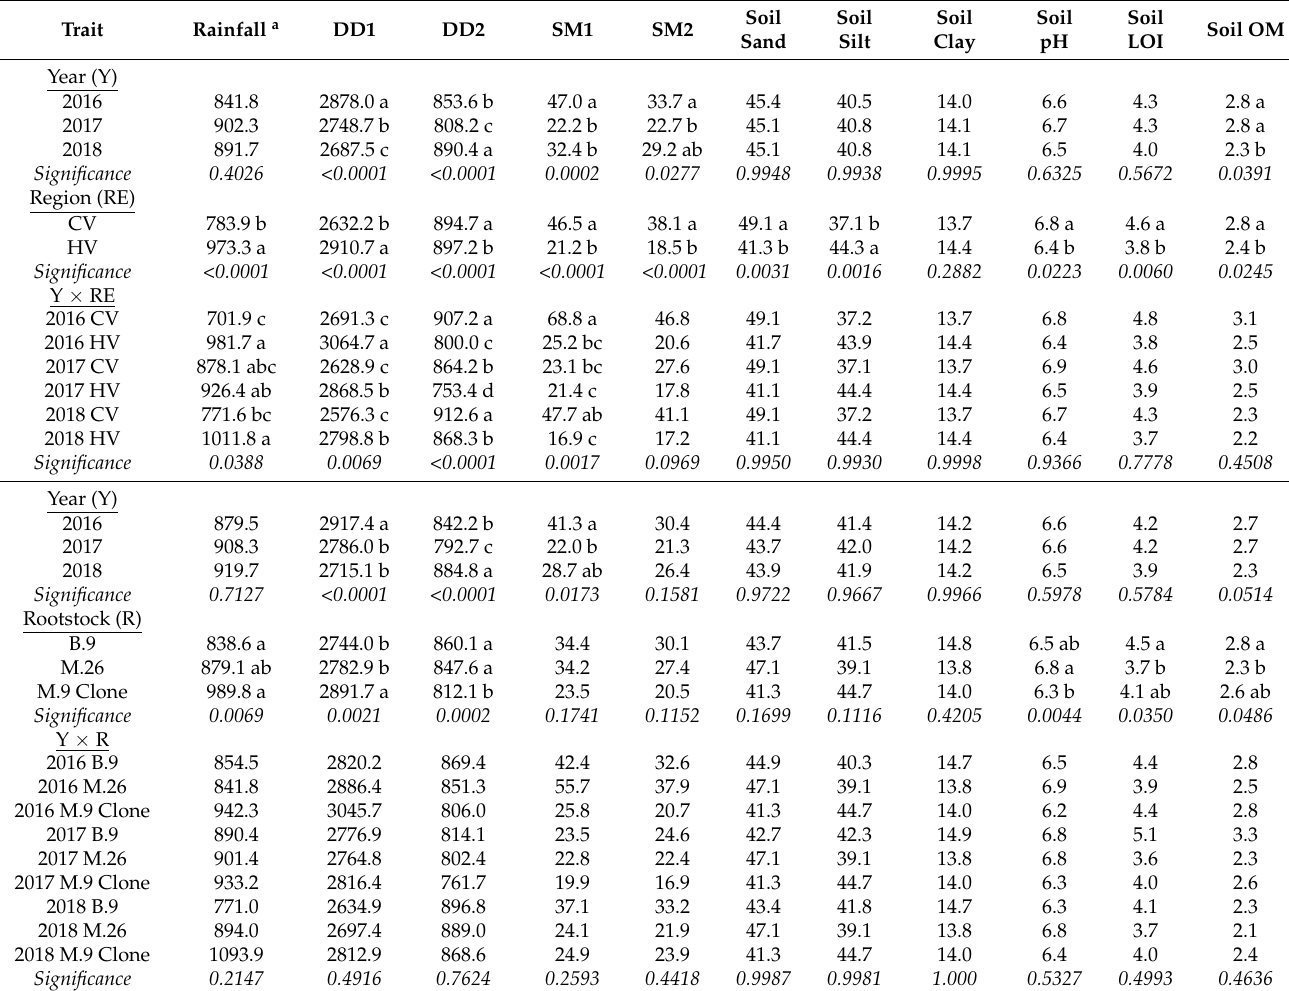
Table 2. Weather and soil conditions for all three years of study (2016, 2017 and 2018) and all three rootstocks (B.9, M.26 and M.9 Clone) from both regions (CV and HV). Trait Rainfall a